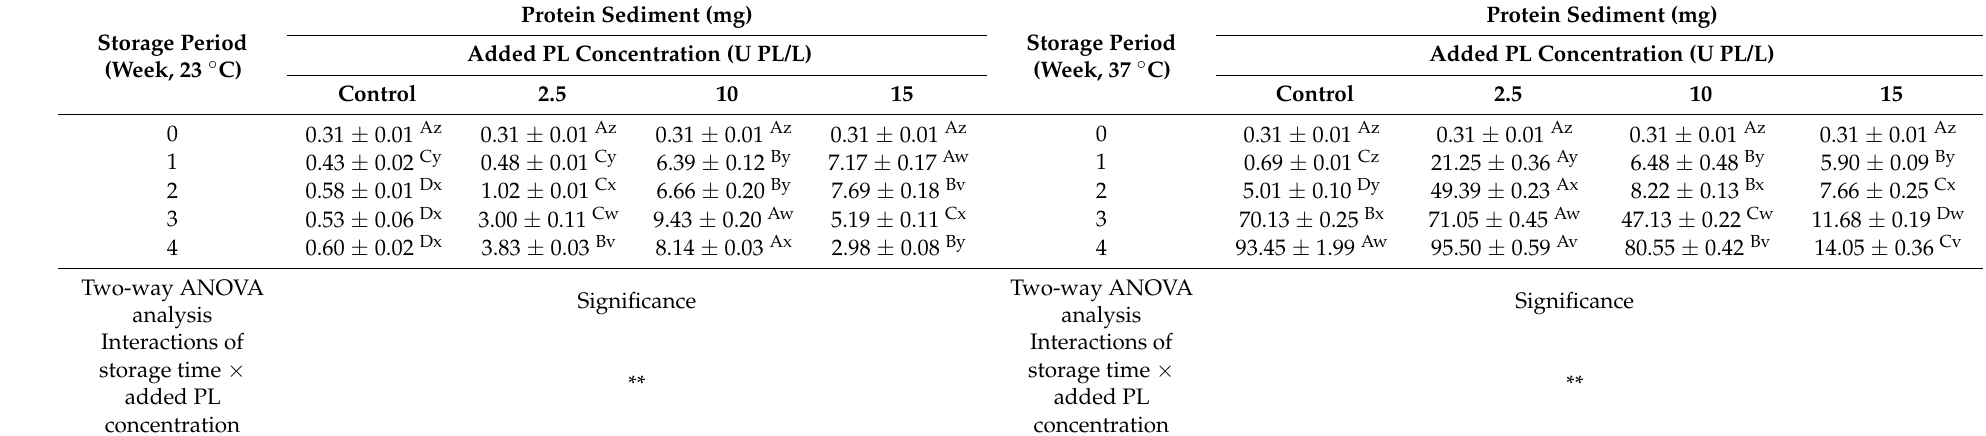
Table 1. Protein sediment analysis of UHT skim milk containing 2.5, 10, and 15 U